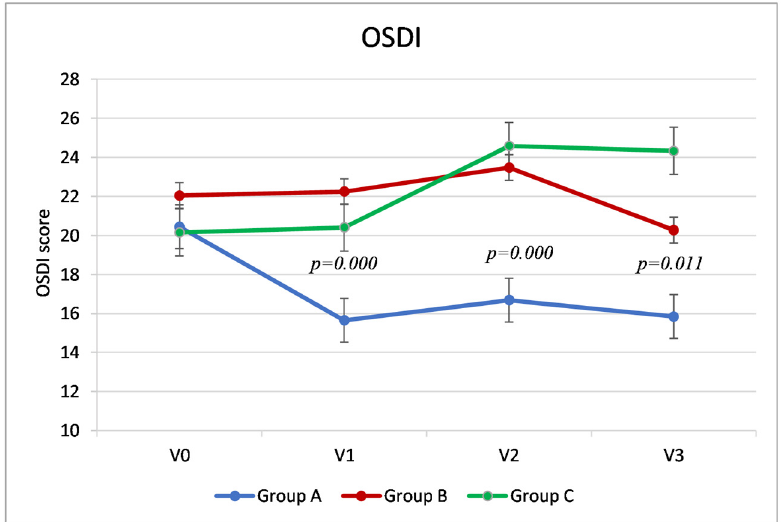
Figure 1. OSDI (Ocular Surface Disease Index) questionnaire scores. The reported p -values refer to the comparisons between Groups A and B at V1, V2 and V3.